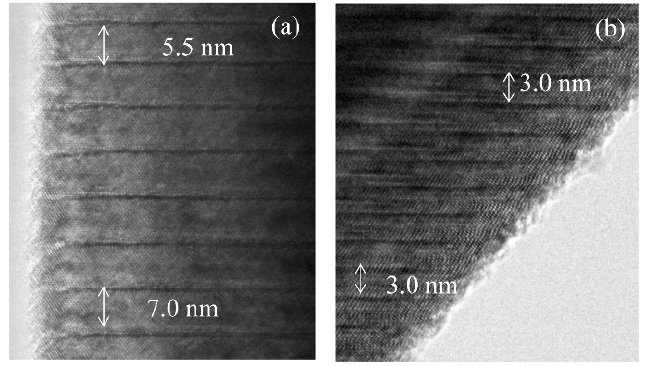
Figure 7. TEM images of LNT with ( a ) 15 mol % and ( b ) 30 mol % at 1237 K for 1 h under 0.35 MPa.